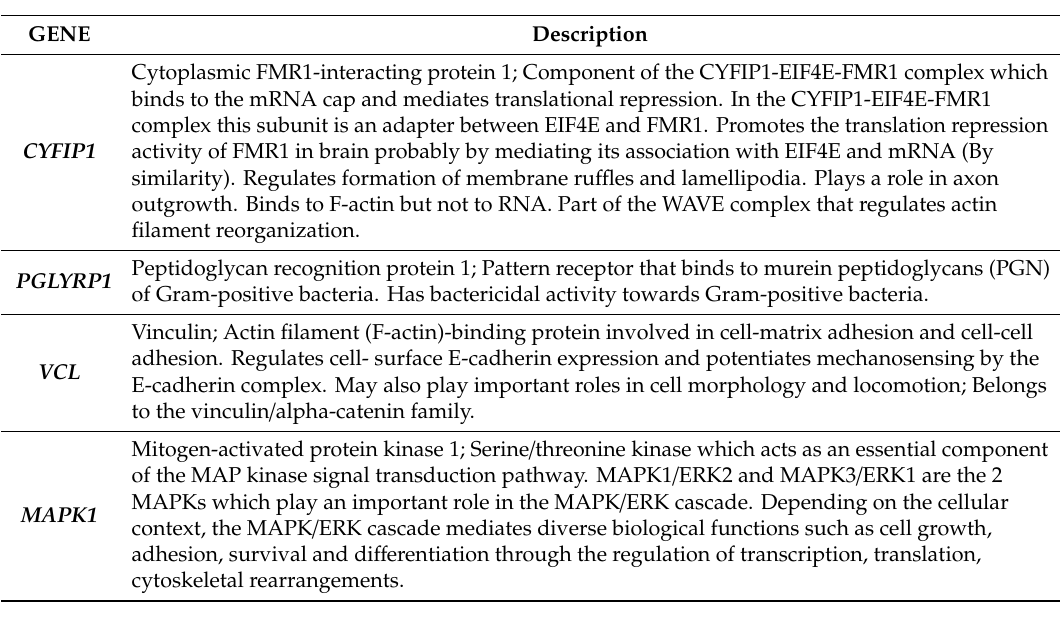
Figure 5. STRING Protein–Protein Interaction Network for CYFIP1 gene with functional interactions with 26 nodes. (Source: STRING.org). Network nodes represent proteins with splice isoforms or post-translational modifications collapsed into each node for all proteins produced by a single protein-coding gene. Edges represent protein-protein associations that are considered specific and meaningful (i.e., proteins jointly contribute to a shared function) (Table 9). (See Figure 2 for legend with a description of symbols and notes on interpreting the interaction of genes and their encoded proteins). CYFIP1 gene protein–protein interactants and their functions for CYFIP1 are listed in Table 11. Table 11. STRING Protein–Protein Interactants and Their Functions for CYFIP1 .